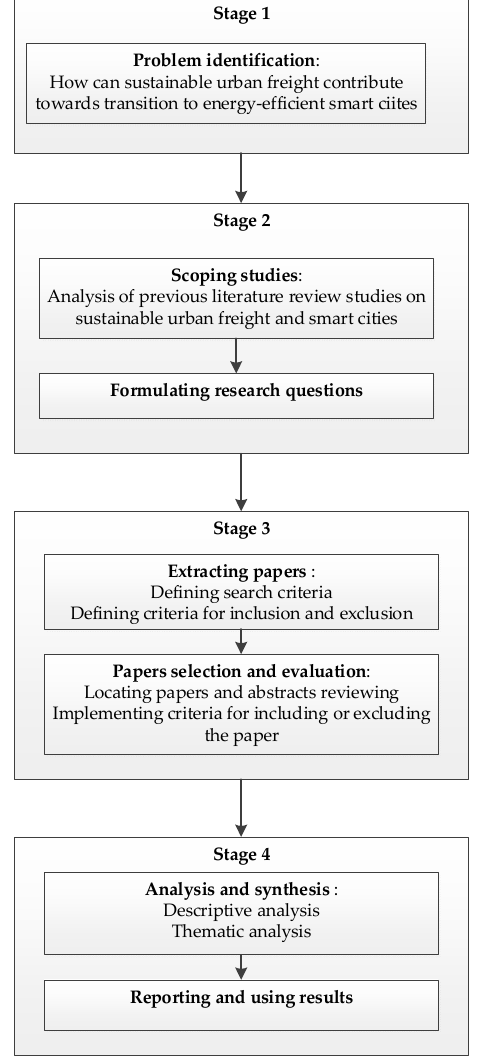
Figure 1. The overview of the research methodology